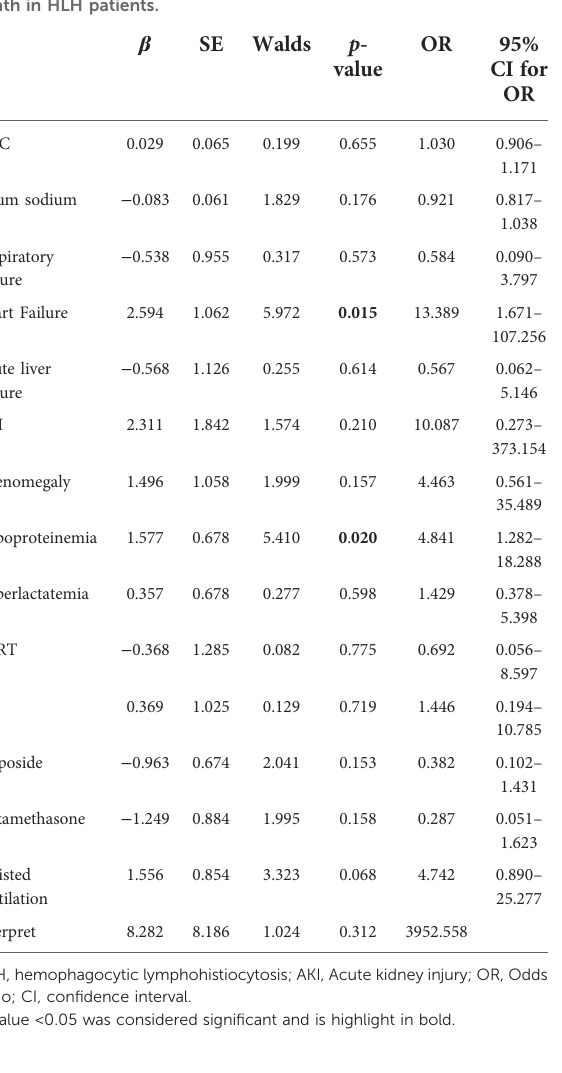
TABLE 4 Multivariable logistic regression analysis for risk factors of death in HLH patients.